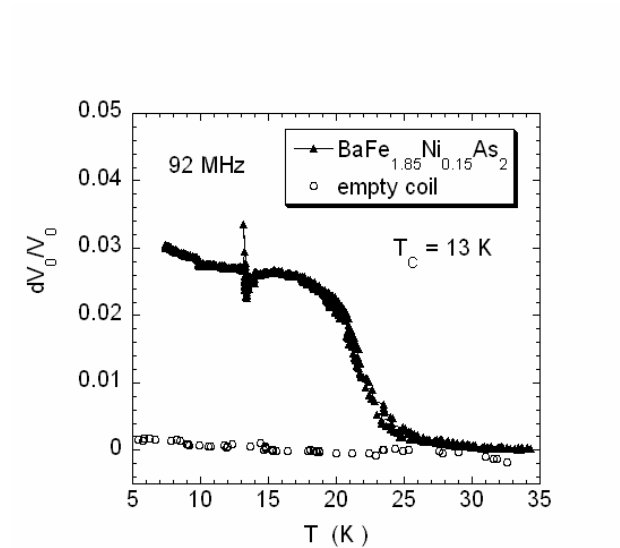
Figure 2: Temperature dependence of the relative change dV 0 /V 0 , LC circuit measured with BaFe 1.85 Ni 0.15 As 2 crystal dimensions 7x5x0.2 mm 3 , superconducting phase transition T C = 13 K and the empty